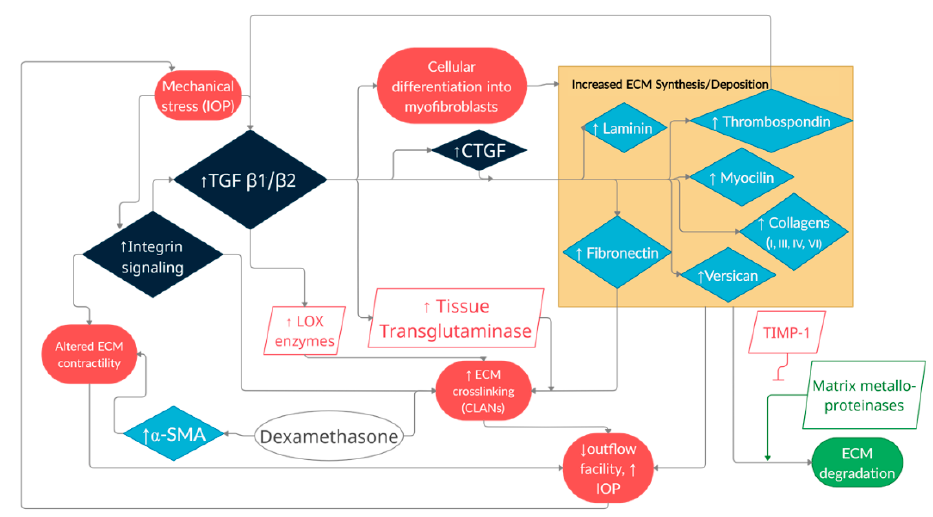
Figure 5. Overview of cellular and extracellular matrix interactions in glaucomatous tissue remod- eling. The interplay of numerous factors, including environmental stressors, enzymatic reactions, growth factors, glycoproteins and proteoglycans as well as cytoskeletal elements all contribute to a feedback loop where outflow facility is disturbed. Red circles indicate negative situational change. Green circle indicates positive situational change. Dark blue diamonds highlight critical signaling factors. Light blue diamonds indicate extracellular matrix glycoproteins and proteoglycans. Red rhombuses indicate negative catalysts. Green rhombus indicates positive catalysts. White circle indicates exogenous factors. ECM: Extracellular matrix; TGF: Transforming growth factor; CTGF: Connective tissue growth factor; α -SMA: Alpha smooth muscle actin; CLANs: Cross-linked actin networks; TIMP-1: Tissue inhibitors of metalloproteinases 1.